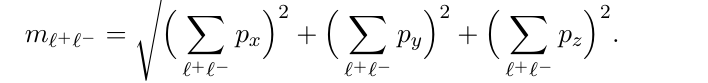
Figure 29 . Distribution of missing energy ( =E verse mass ( H T ) for signal events ‘ + ‘ (cid:0) + ( =E p s = 14